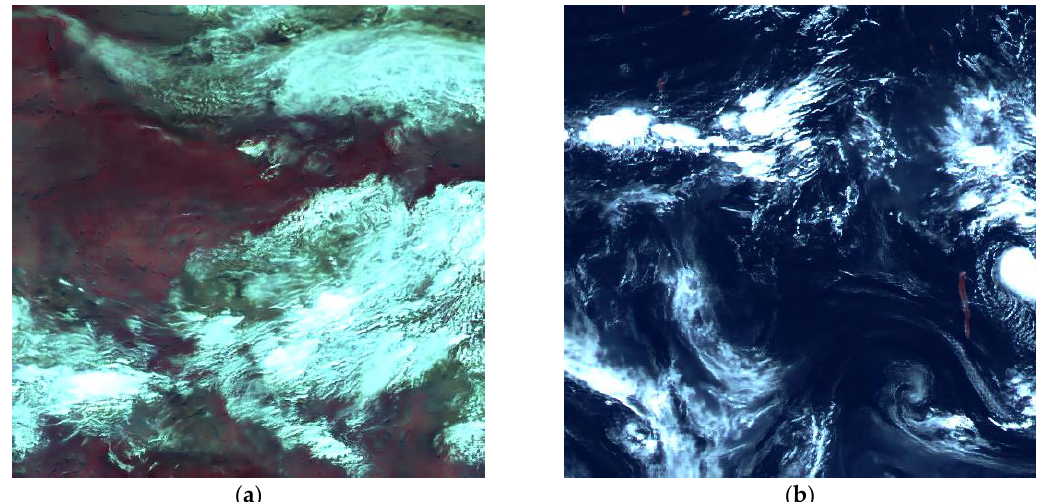
Figure 4. Visual comparison of different models for translation from infrared spectrum domain to visible spectrum domain. Subfigures ( a ) and subfigures ( b ) are two independent test cases.